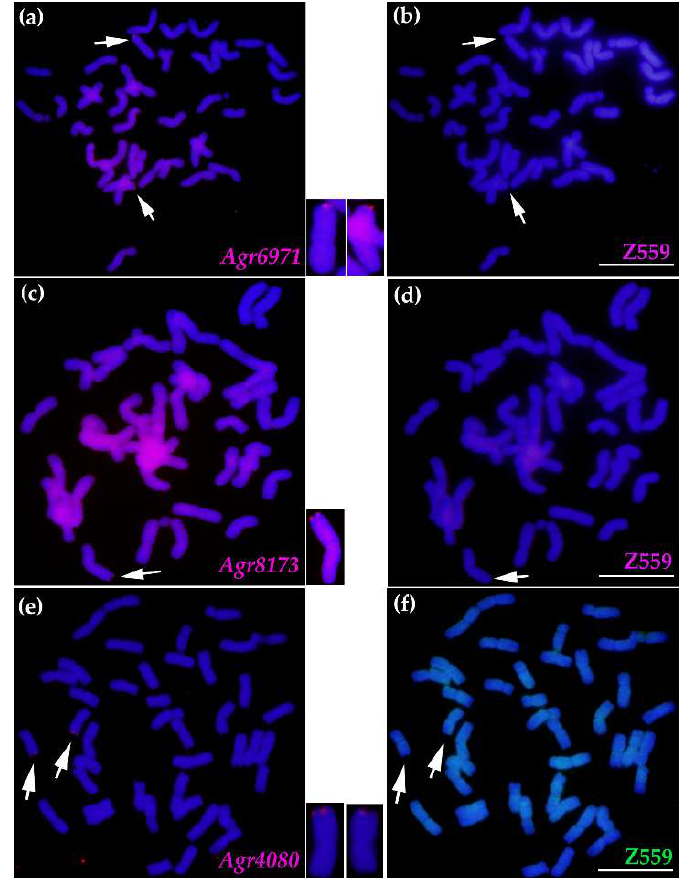
Figure 7. The FISH detection of A . cristatum P genomic components of the partial breeding lines using three gene FISH probes. ( a , c , e ) The A . cristatum P genomic components of the breeding lines can be detected using three gene probes. A . cristatum 6P chromosomal segments were in red, while wheat chromosomes were in blue strained by DAPI. The white arrows indicated the A . cristatum chromatin in the wheat background. ( b , d , f ) The A . cristatum P genomic components of the breeding lines cannot be traced by the DNA of A . cristatum “Z559” as the probe. (scale bar = 10 µm). Table 2. The agronomic traits of wheat– A . cristatum breeding lines in 2019–2020.